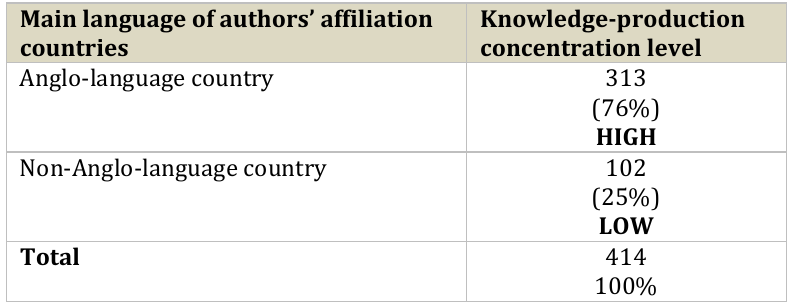
Table 3: Level of knowledge-production concentration in Crimes of the powerful studies in linguistic terms (Anglo language/non- Anglo language) according to main authors’ affiliation in WoS Core